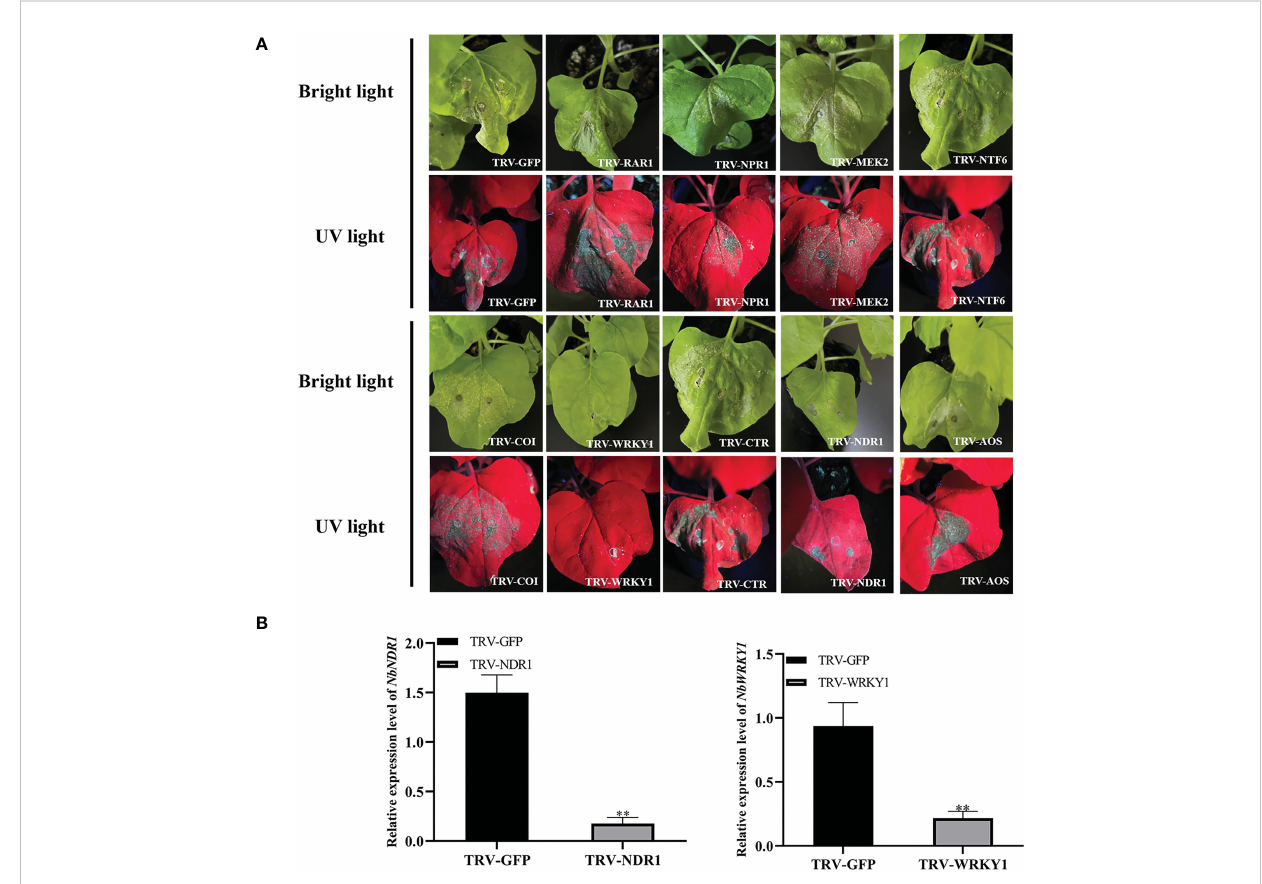
FIGURE 6 Effect of signaling cascade silencing on RepA-induced cell death in Nicotiana benthamiana . (A) Disease symptoms in silenced N. benthamiana plants at 3 days post-in fi ltration (dpi) with RepA-GFP. (B) The expression level of NbWRKY1 was calculated using the 2 − DD Ct method with the housekeeping gene NbACTIN (Student ’ s t-test, ** p < 0.01). Each experiment was repeated four times and at least fi ve plants were used per biological